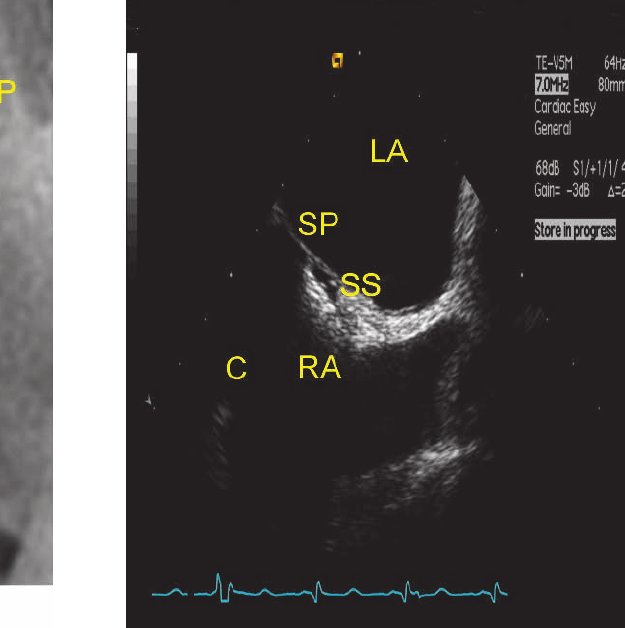
Figure 2 Left: Devices under suction during heat application adhering to both the